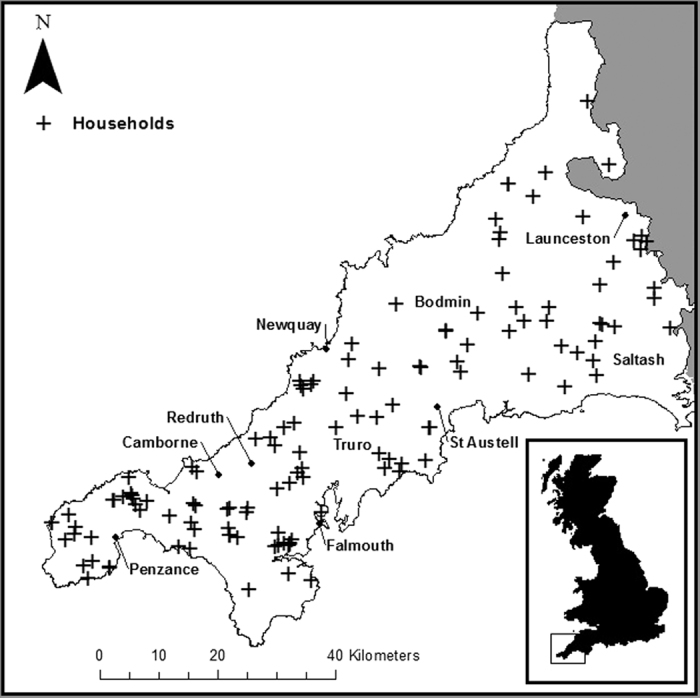
Spatial distribution of sampled households.Compiled using ArcMap 10.1.